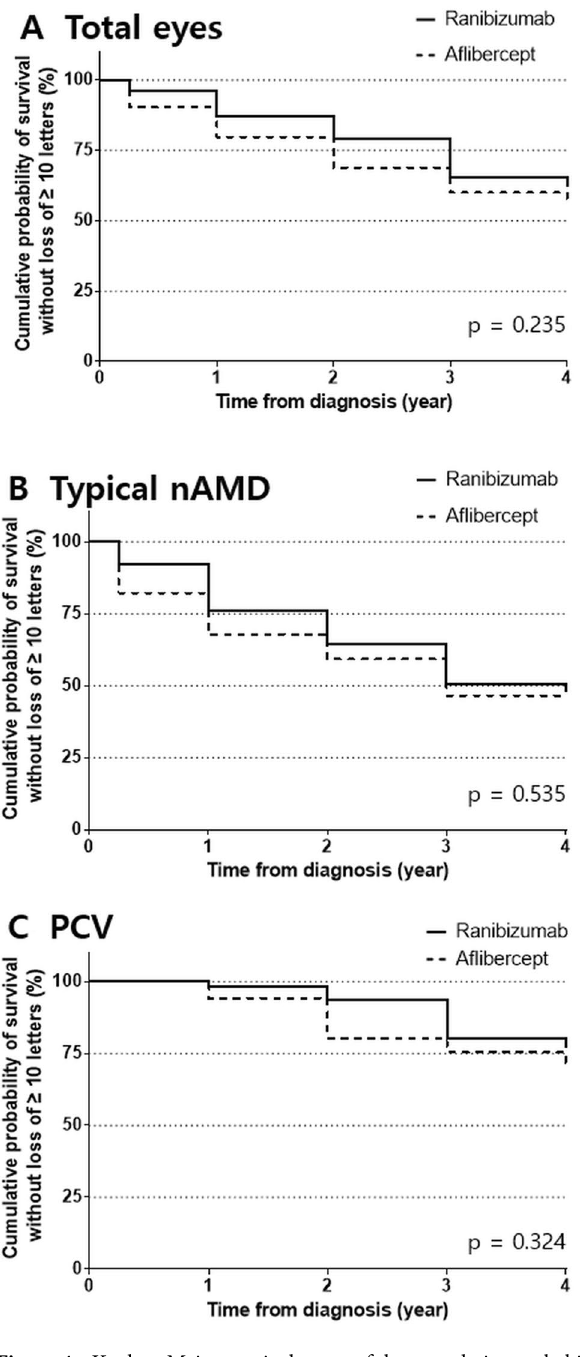
Figure 4. Kaplan–Meier survival curve of the cumulative probability of survival without significant vision loss. ( A ) Total eyes, ( B ) typical neovascular age-related macular degeneration subgroup, and ( C ) polypoidal choroidal vasculopathy